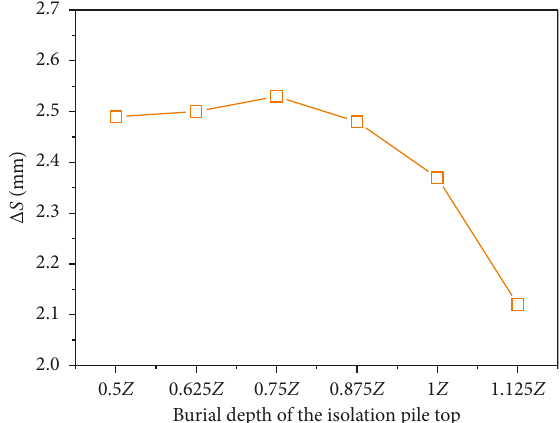
Figure 26: Decrement in maximum horizontal displacement of the tunnel structure under different isolation pile top depths. Table 9: Reinforcement effects of isolation piles on torsional de- formation of the tunnel structure under different isolation pile top